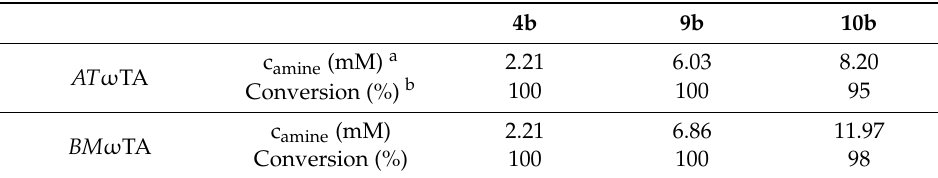
Table 3. Reductive amination of